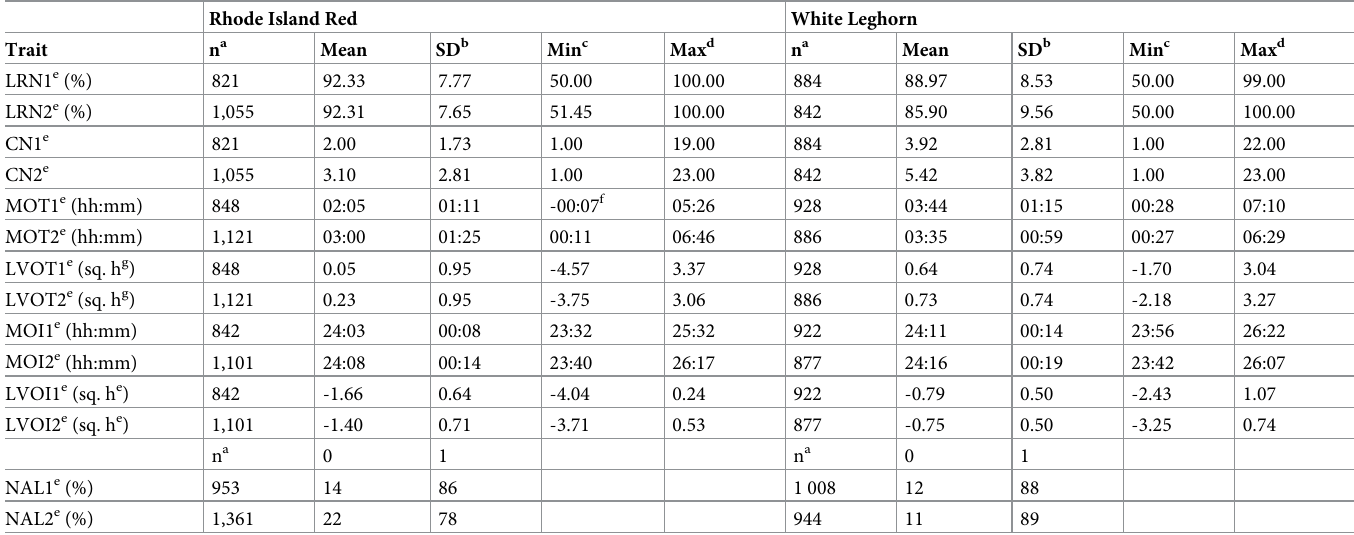
Table 2. Phenotypic data statistics for the Rhode Island Red and White Leghorn lines. Rhode Island